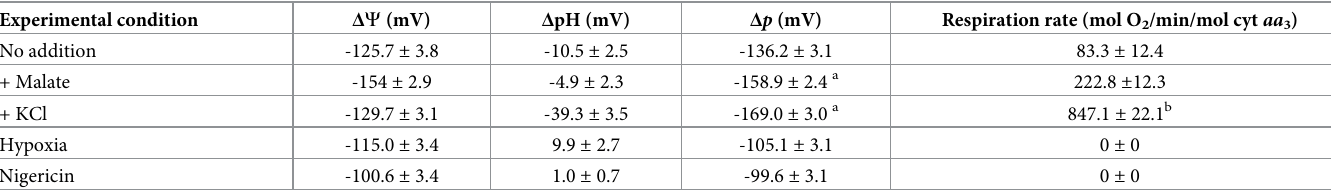
Table 4. Membrane potential ( Δ C ), pH gradient ( Δ pH) and proton motive force ( Δ p ) quantitation in malate-grown P . denitrificans cells.